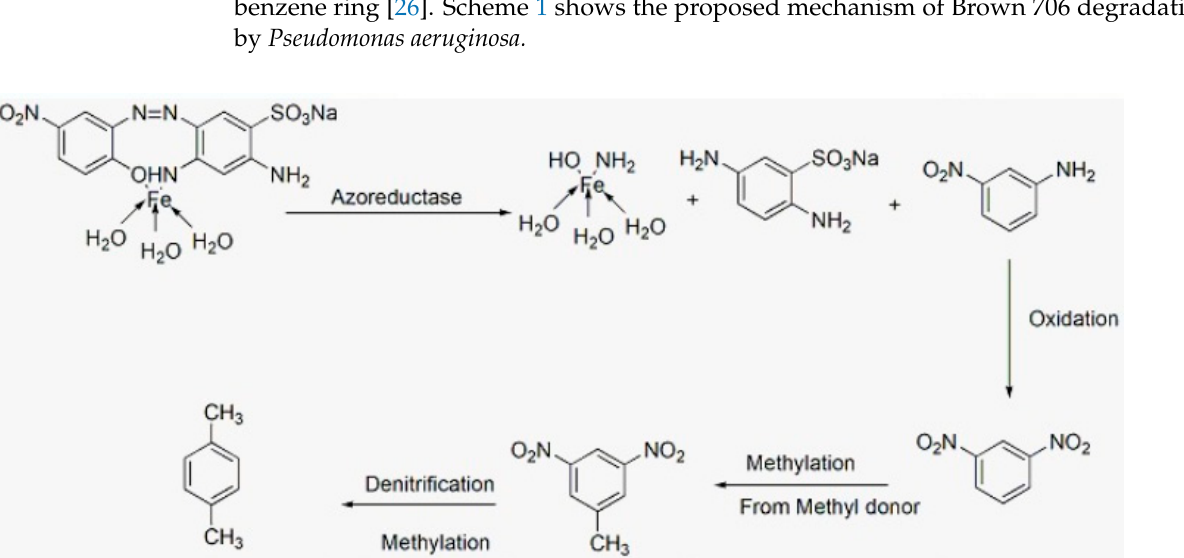
Figure 14. 13 C NMR after Pseudomonas aeruginosa